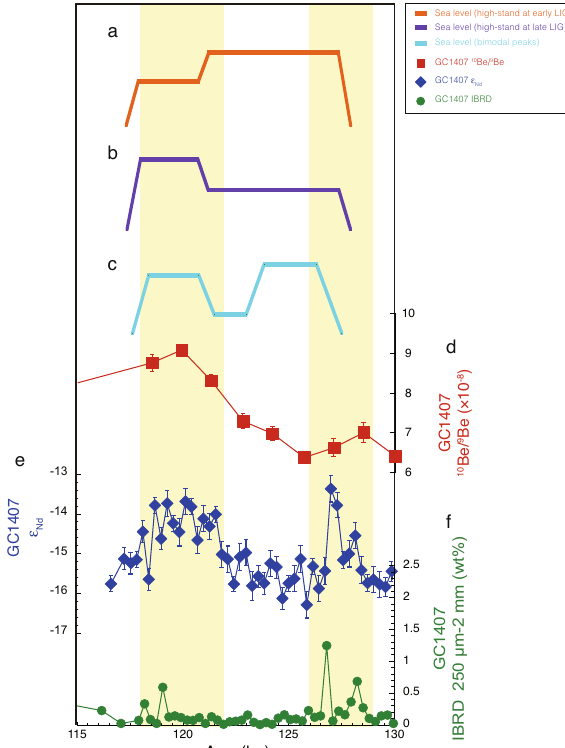
Fig. 4 | Comparison of core GC1407 records to sea-level scenarios during the Last Interglacial. a – c Simpli fi ed eustatic sea-level records from a range of global sites 1 – 4,6 – 9 . d Authigenic 10 Be/ 9 Be ratios from core GC1407 (red squares, this study) (errorbarsare1s.d.). e DetritalsedimentNdisotopes( ε Nd )fromcoreGC1407(dark blue diamonds, this study) (error bars are 2s.d.). f Iceberg rafted debris (IBRD, percent 250 µ m – 2mm) from core GC1407 (green circles, this study). Yellow bars indicate two episodes of inferred Wilkes Subglacial Basin ice mass loss during the early and late Last Interglacial.